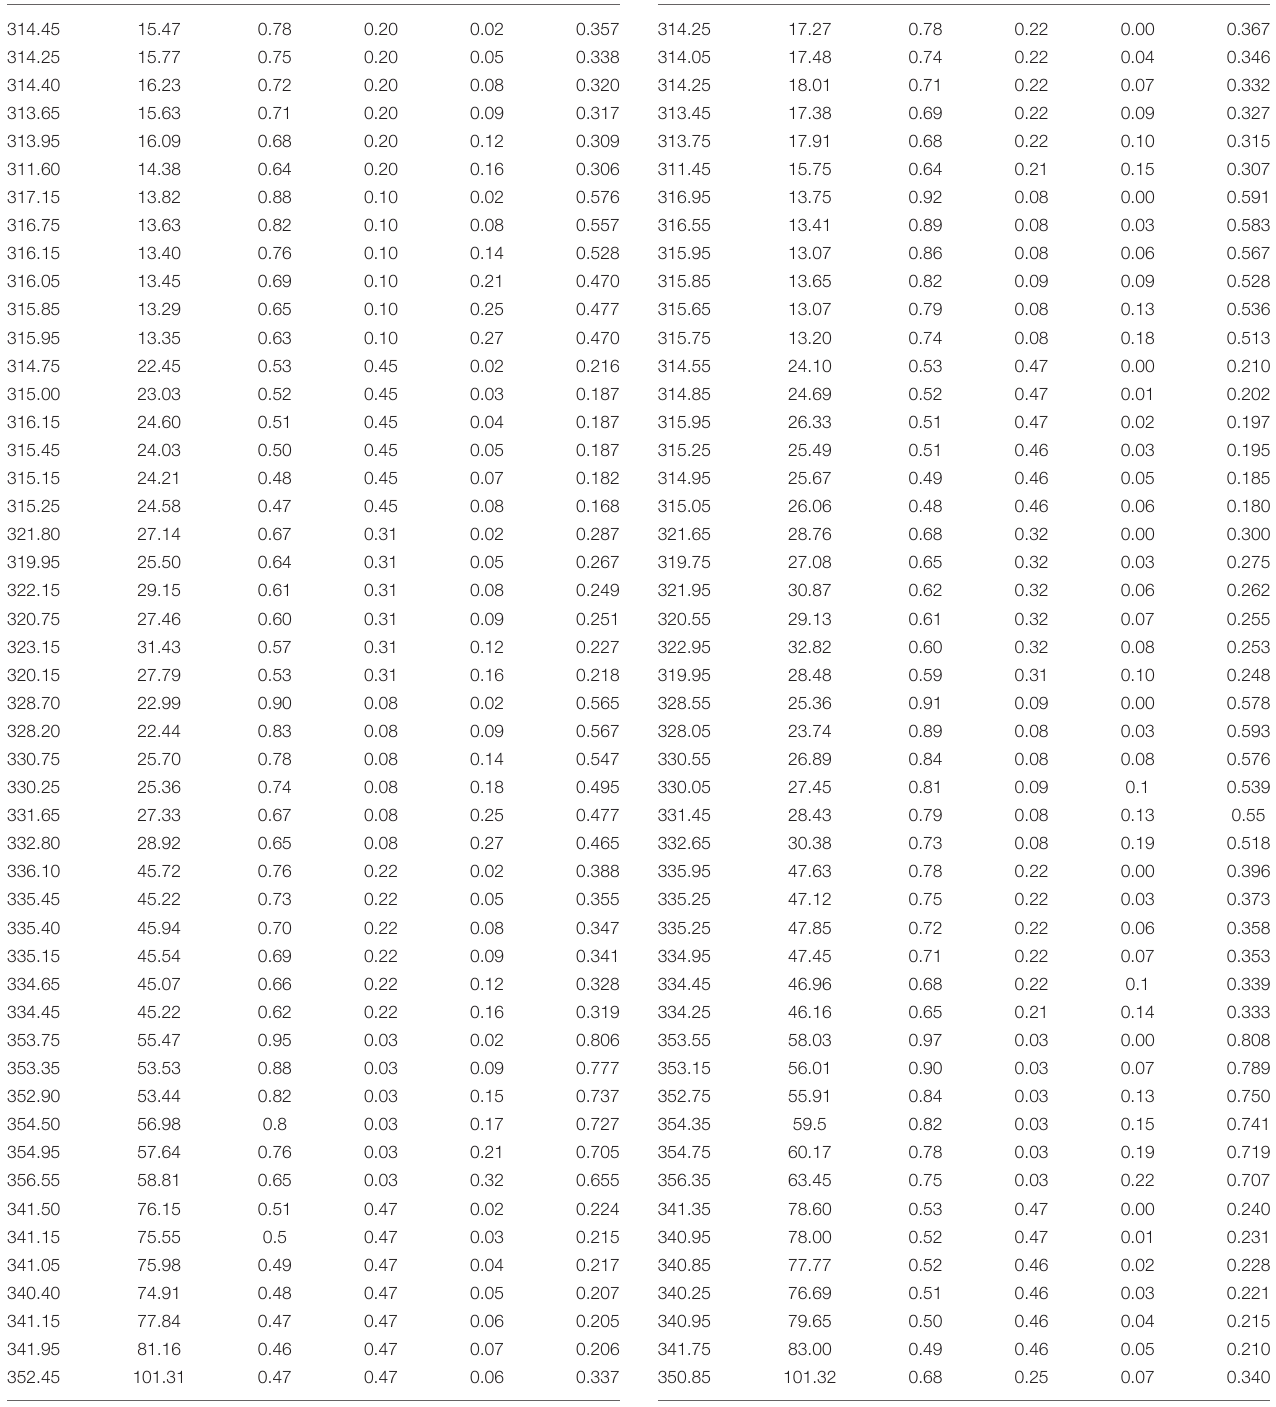
TABLE 1 | Experimental VLE data for the H 2 O(1) + CH 3 OH(2) + NaI(3)